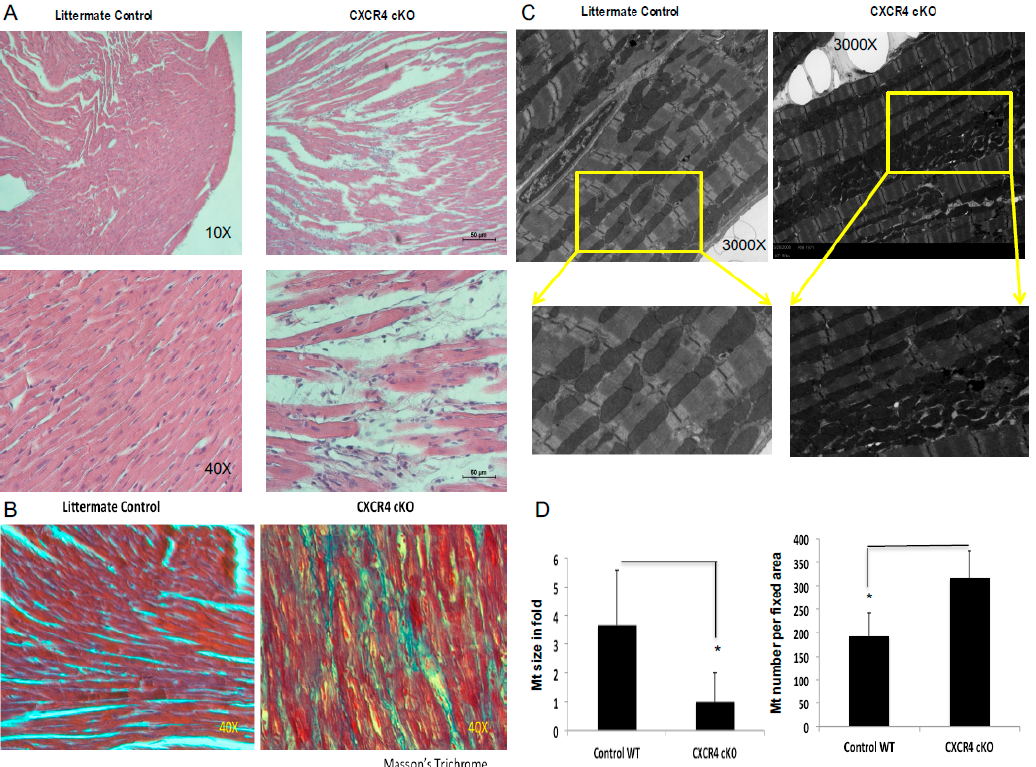
Figure 2. Histological assessment of CXCR4 cKO hearts. ( A ) We used conventional hematoxylin and eosin (H&E). Histological staining was done on left ventricular sections at the mid-papillary level and hearts were examined at low (10 × ) and high (40 × ) magnification. Images were captured via light microscopy at 40 × magnification and a composite image of each sample was constructed. CXCR4 cKO hearts revealed significant structural abnormalities i.e., cardiac myocyte hypertrophy and the presence of cellular infiltrates at 6-months of age. ( B ) Masson’s Trichrome staining was used to assess for interstitial fibrosis. ( C ) Transition electron microscopy images were taken at 3000–5000 × magnifications. Random pictures of each section were taken at 3000–5000 × magnifications to count the number of mitochondria and at 1000× magnification to count the number of dark and light fibers. ( D ) After images were acquired, they were analyzed using ImageJ in order to count the number of